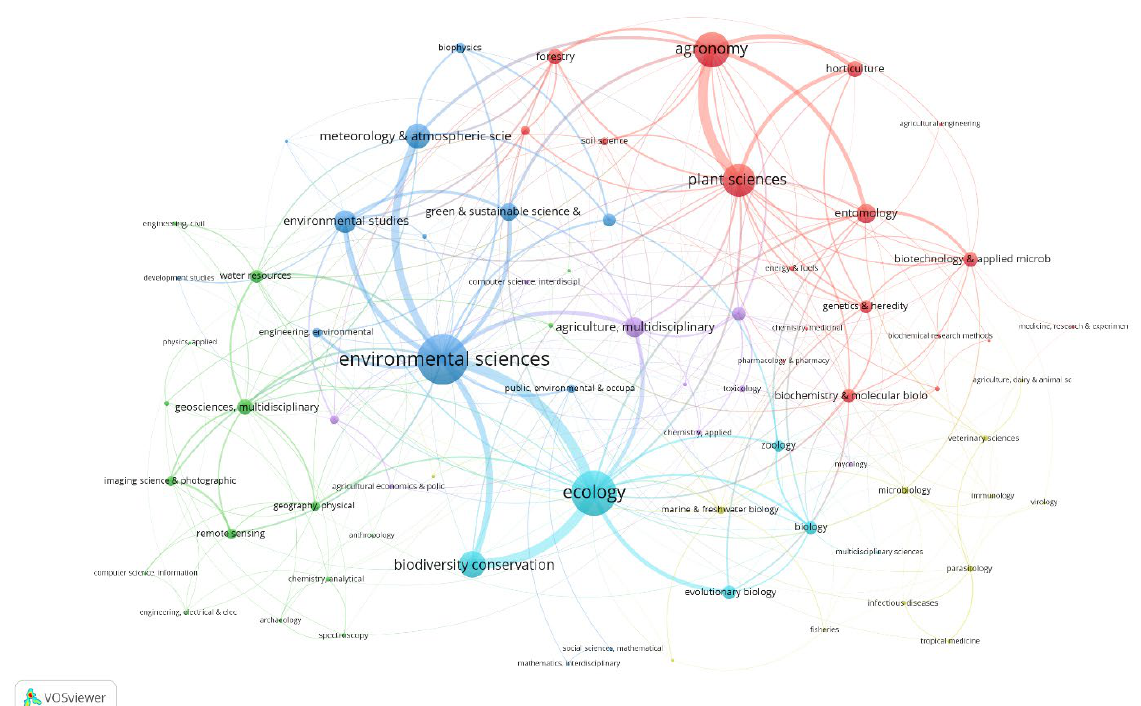
Figure 2. Distribution map of discipline categories.